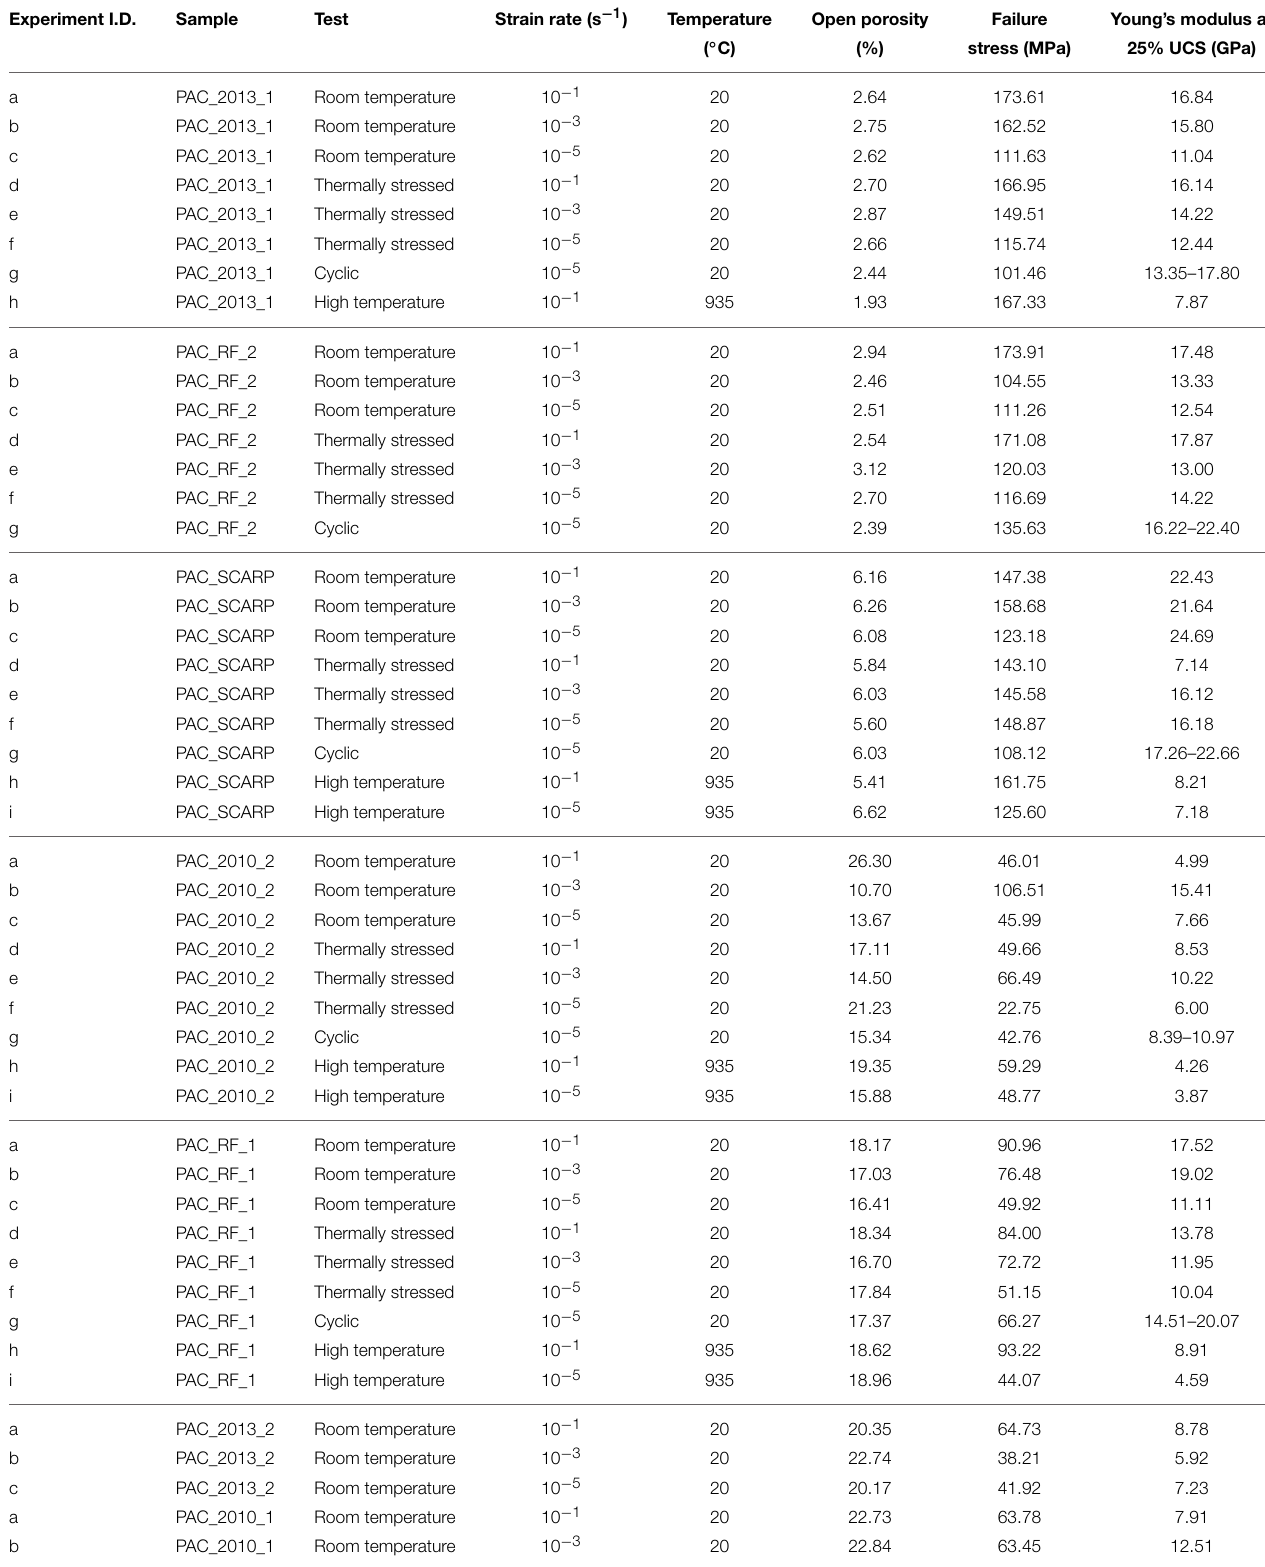
TABLE 3 | Summary of all results, including porosity, uniaxial compressive strength and Young’s Modulus for each sample type by experiment I.D. Experiment